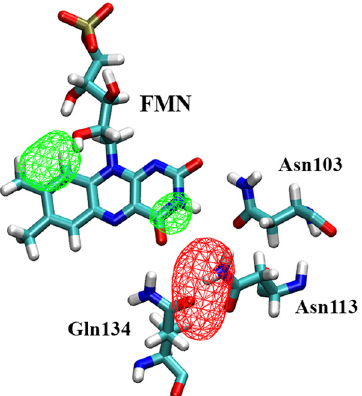
Figure 5: Occupancy volume maps of oxygen ( red, isosurface value 5% ) and water ( green, isosurface value 25% ) in the binding pocket of C71S variant ( replica C71S_r1 is shown as an example ) . The volume maps were averaged on the whole trajectory after skipping the fi rst 5 ns. A neighbourhood of 8 Å around atom O4 of FMN cofactor includes the whole binding pocket. The FMN and the HB networking triad are shown as a